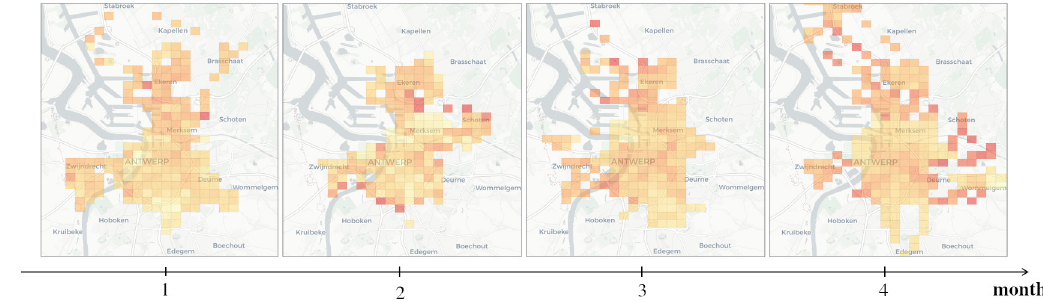
Figure 3. Example of a general exploratory task as a composite of multiple elementary